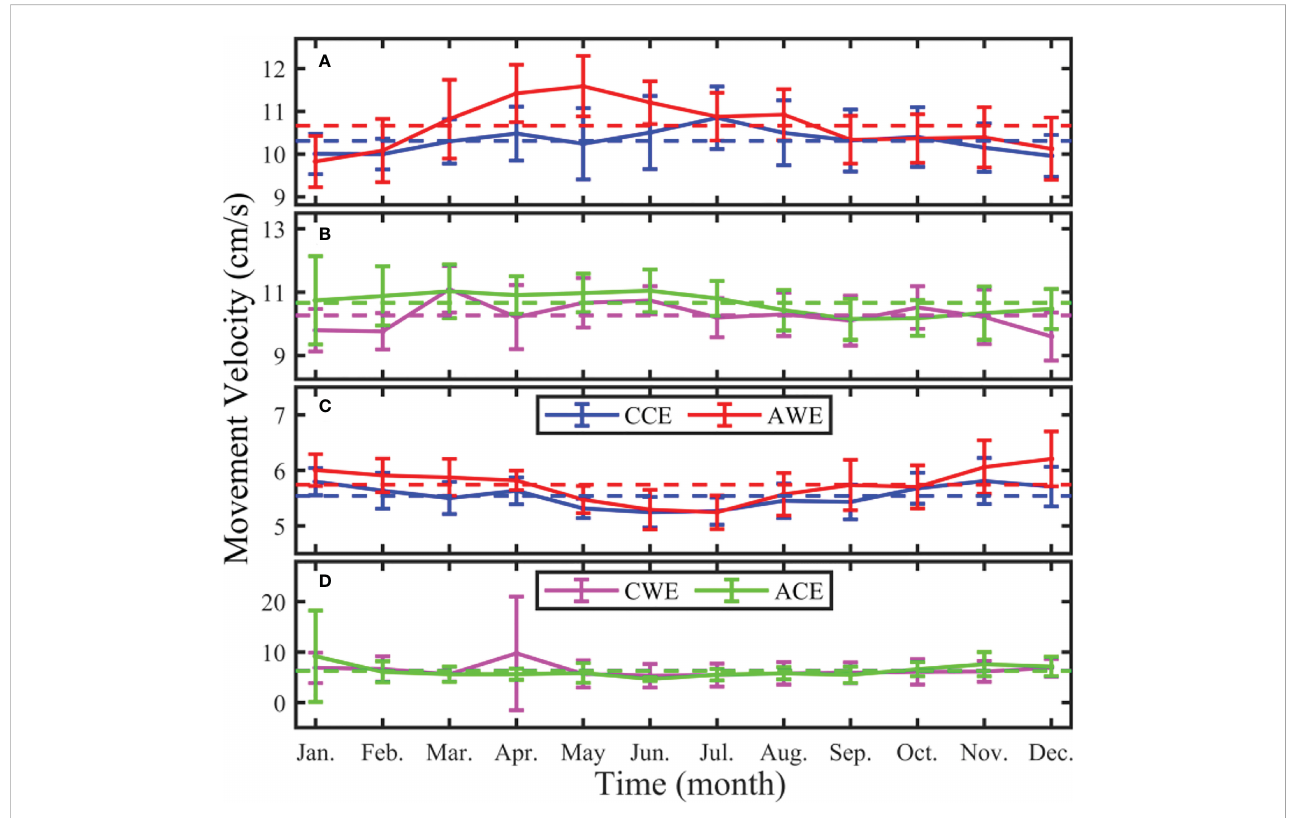
FIGURE 4 Monthly distribution of multi-year (2008 ~ 2017) average eddy horizontal moving velocity at the sea surface (A, B) and 1,000 m (C, D) in the STCC area. Blue, red, pink, and green curves represent cyclonic cold-core eddy, anticyclonic warm-core eddy, cyclonic warm-core eddy, and anticyclonic cold- core eddy, respectively. The bar line represents the standard deviation, and the dotted line represents the multi-year average